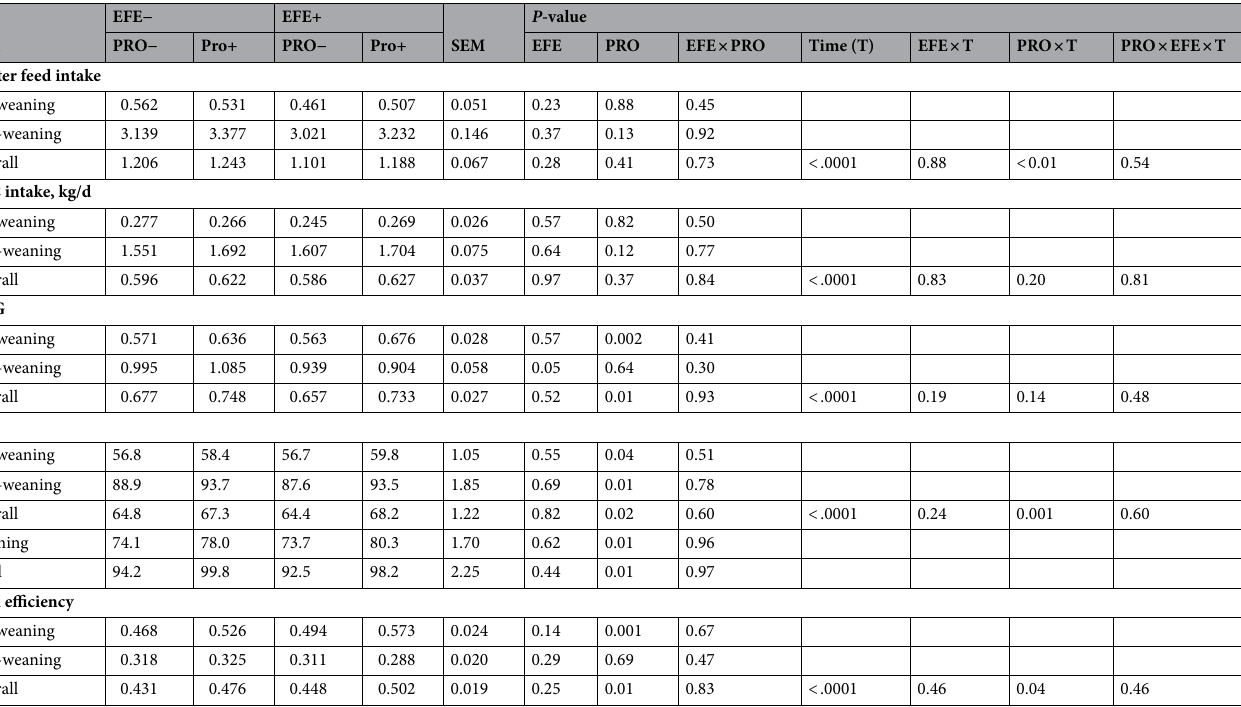
Table 2. Least squares means for starter feed intake, NFC intake, ADG, body weight (BW), and feed efficiency in dairy calves supplemented with or without exogenous fibrolytic enzymes (EFE) and probiotic (PRO) in the starter diets (n = 12 calves per treatment). Treatments were (1) calves fed diets without exogenous fibrolytic enzymes (EFE)-treated wheat straw and probiotic supplement (EFE-Pro−), (2) calves fed diets of EFE-treated wheat straw but with probiotic supplement (2 g/d/calf; EFE-Pro+), (3) calves fed EFE-treated wheat straw (2 g/d/calf) but without probiotic supplement (EFE+ Pro−), (4) calves fed EFE-treated wheat straw and probiotic supplement (EFE+ Pro+). Exogenous fibrolytic enzymes were applied to wheat